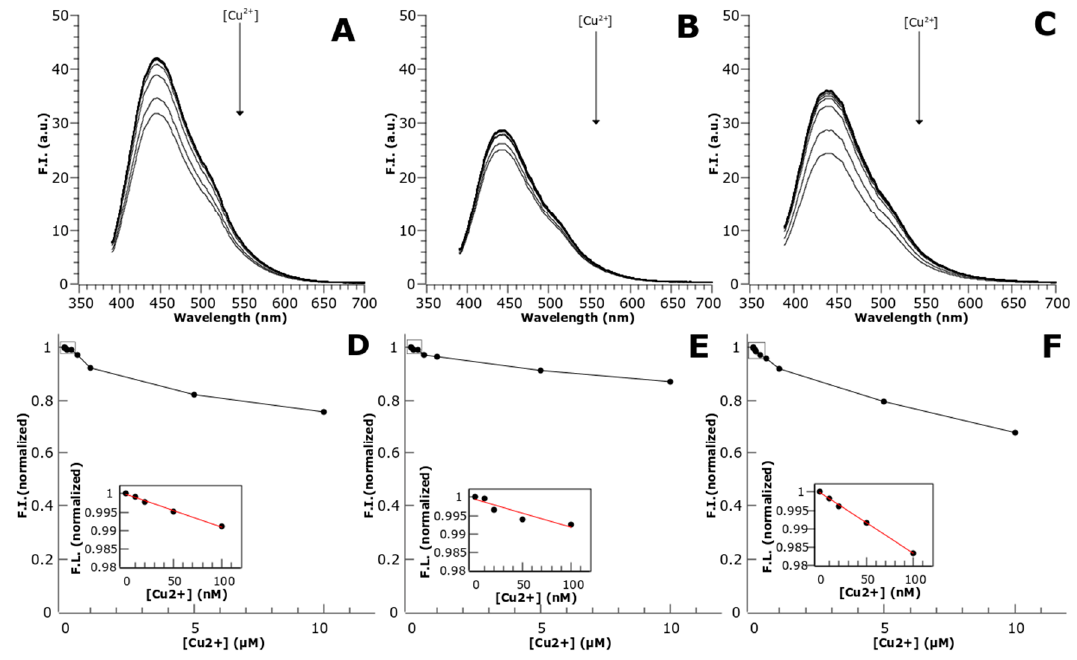
Figure 6. Cu detection by protein-stabilized nanoclusters. Fluorescence emission spectra of CTPR templated metal NCs in the presence of different Cu 2+ concentrations (upper panels) C3_cys-CuNCs ( A ); C3_cys-AgNCs ( B ); and C3_cys-AuNCs ( C ). Normalized fluorescence vs. Cu 2+ concentration plots (lower panels). C3_cys-CuNCs ( D ); C3_cys-AgNCs ( E ); and C3_cys-AuNCs ( F ).